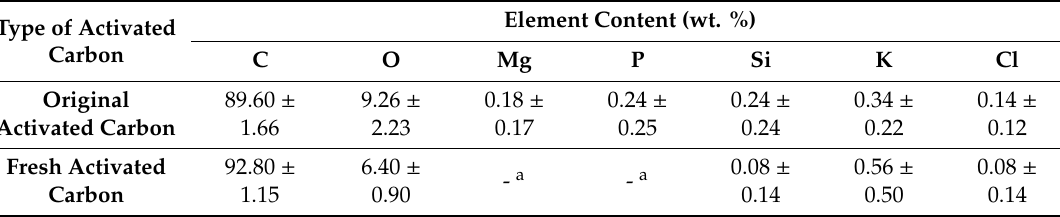
Table 1. Surface elemental characteristics of original and fresh activated carbons.